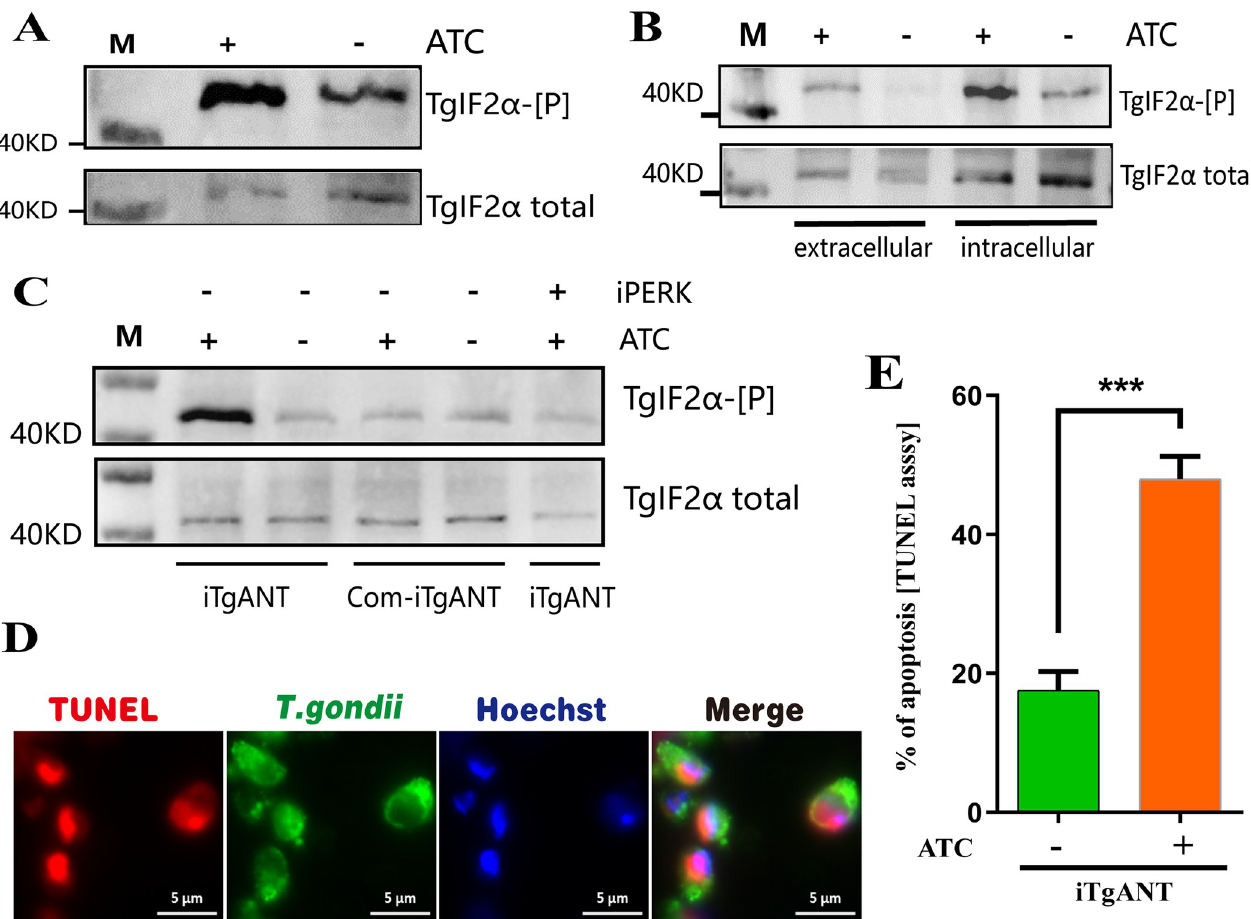
Fig 10. ER stress and apoptosis detection. (A) iTgANT strain were treated with 0.5 μ g/ml ATc for 36h or left untreated, subsequently collected the parasites. They were subjected to Western blot analyses using mouse anti-TgIF2 α -P and rabbit anti-TgIF2 α . (B) Intracellular parasites were treated with 0.5 μ g/ml ATc for 36hor left untreated, subsequently collected the extracellular and intracellular parasites. They were subjected to Western blot analyses using mouse anti- TgIF2 α -P and rabbit anti-TgIF2 α . (C) iTgANT strain and Com-iTgANT were treated with 0.5 μ g/ml ATc for 36hor left untreated, subsequently collected the parasites. Besides, the iTgANT strain was treated with ATc for 33h and then add the iPERK for 3h to verify the phosphorylation of TgIF2 α is caused by ER stress. All the samples were subjected to Western blot analyses using mouse anti-TgIF2 α -P and rabbit anti-TgIF2 α . (D) Morphology of iTgANT strain (green, GRA7) and TUNEL labeling in situ (red) following treatment with ATc for 36h. (E) Mean percentages ± SEM of TUNEL-positive T . gondii , results are from three independent experiments, ��� P � 0.001, Student’s